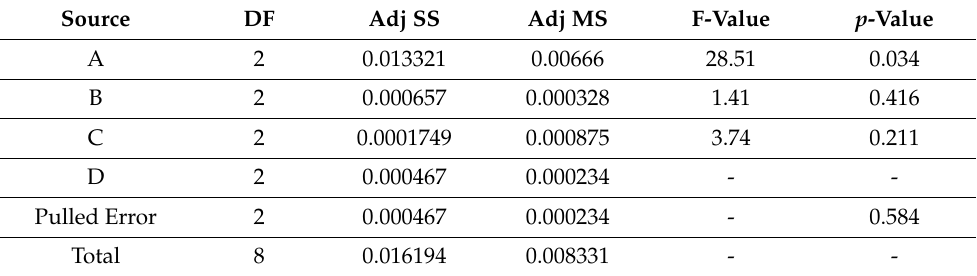
Table 7. Response of variable parameters of